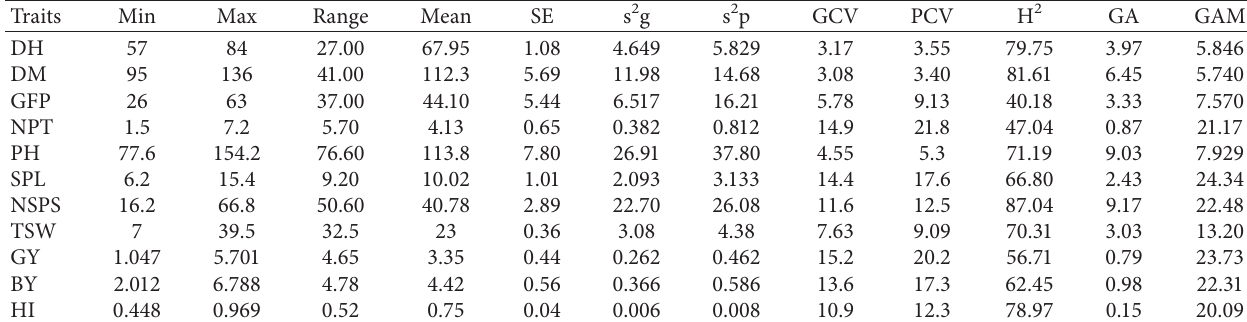
Table 2: Mean, range, phenotypic and genotypic variances, and coefficient of variations; heritability in broad sense and genetic advance for eleven quantitative traits of bread wheat germplasm.